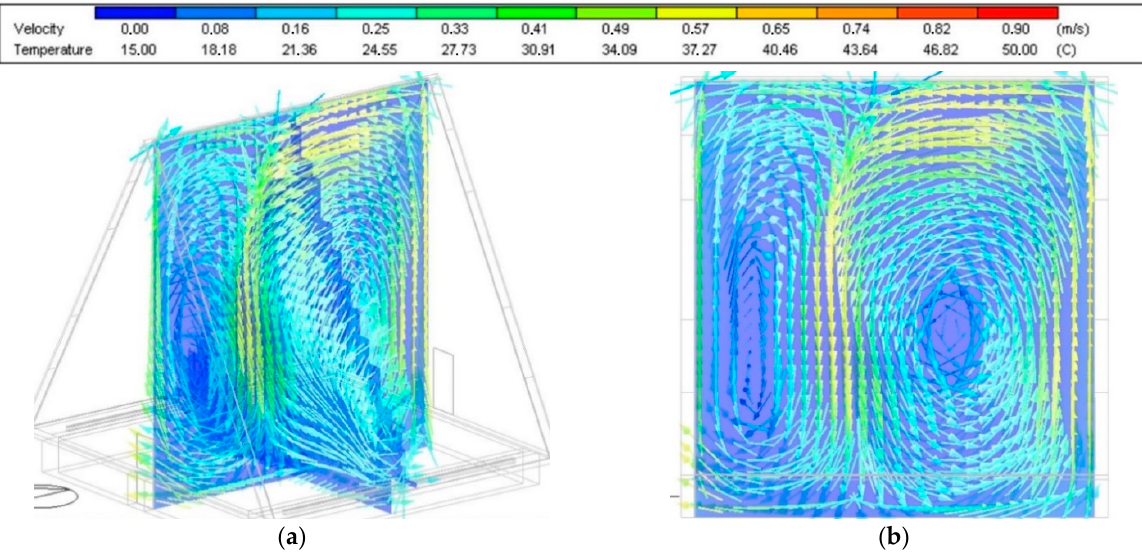
Figure 17. Simulated airflow paths on 6.6. at 2:00 a.m. in position of: ( a ) transverse sections; ( b ) longitudinal section.